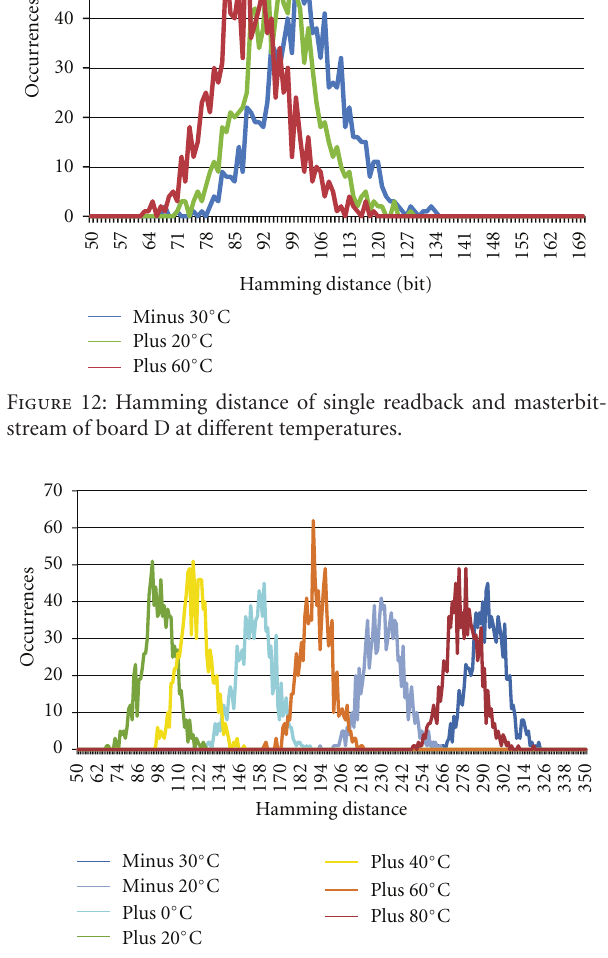
Figure 13: Matching device identification with master bitstream generated at 20 ◦ C and identification readback temperature range from − 30 ◦ C to +80 ◦ C (1k measurements at each temperature